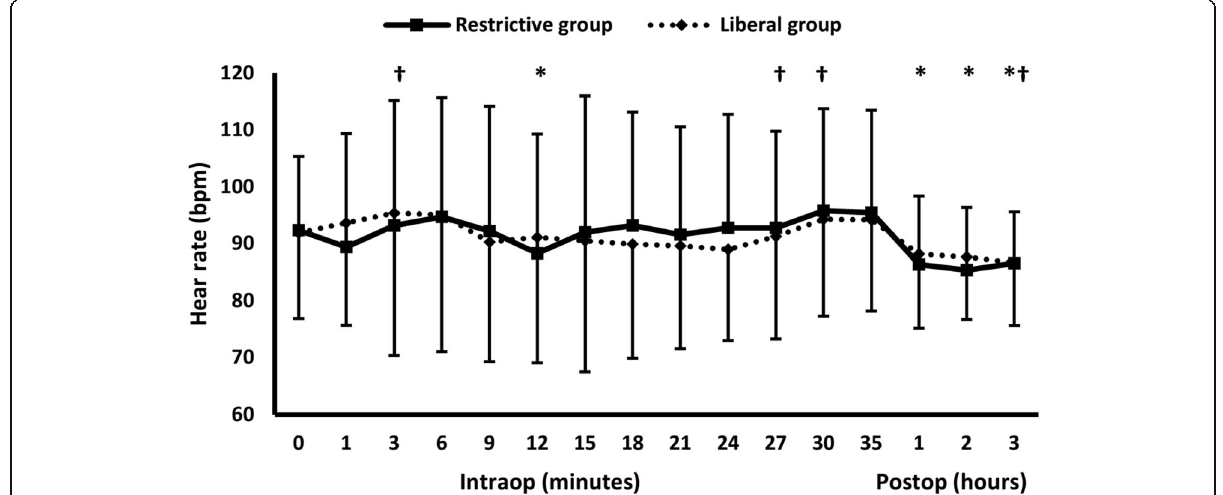
Fig. 3 Heart rate. * denotes statistical significance compared to the baseline reading within restrictive group, † denotes statistical significance